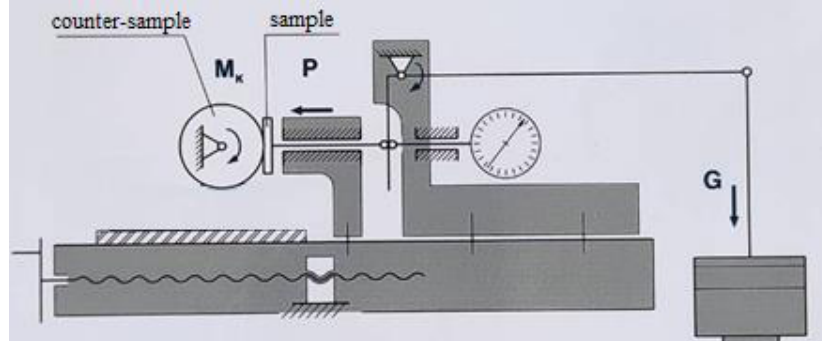
Fig. 2. Diagram of the test machine for determination of tribotechnical characteristics of